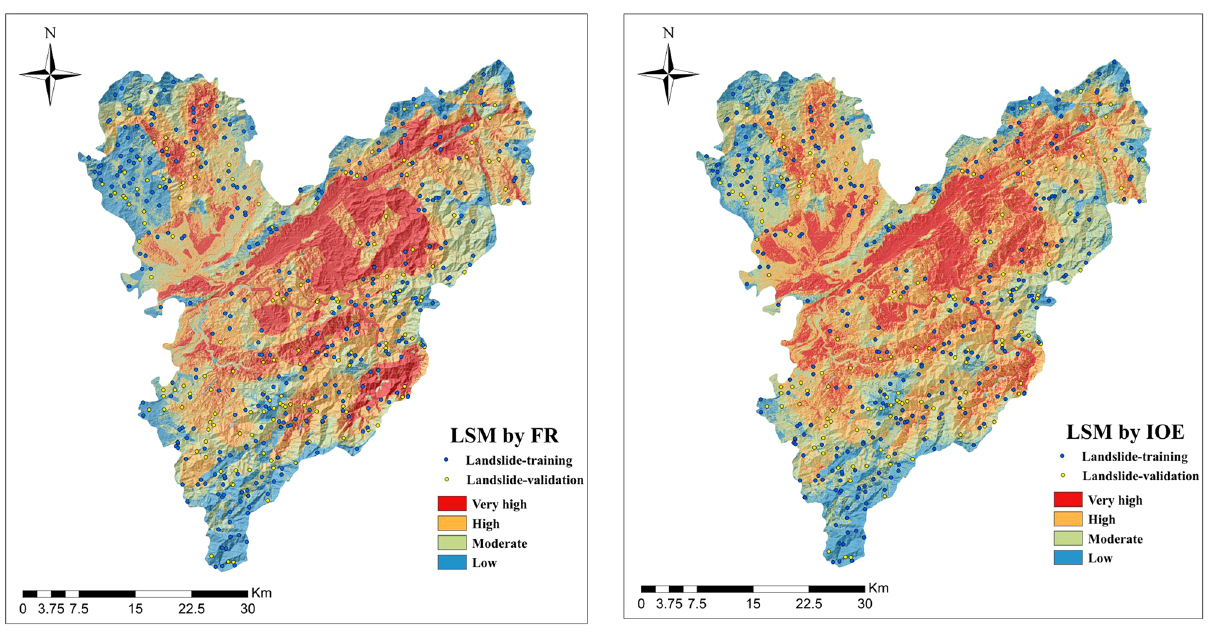
Figure 4: Landslide susceptibility map derived by the FR model. Figure 5: Landslide susceptibility map derived by the IOE model.